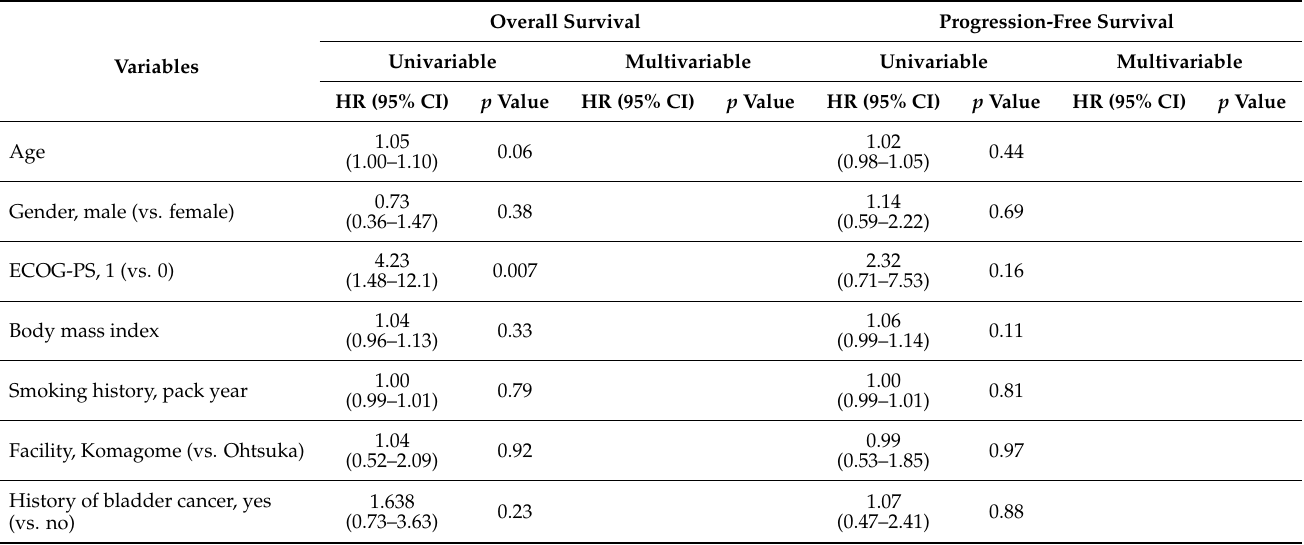
Table 2. Variables associated with overall and progression-free survival in 143 upper tract urothelial carcinoma patients undergoing radical